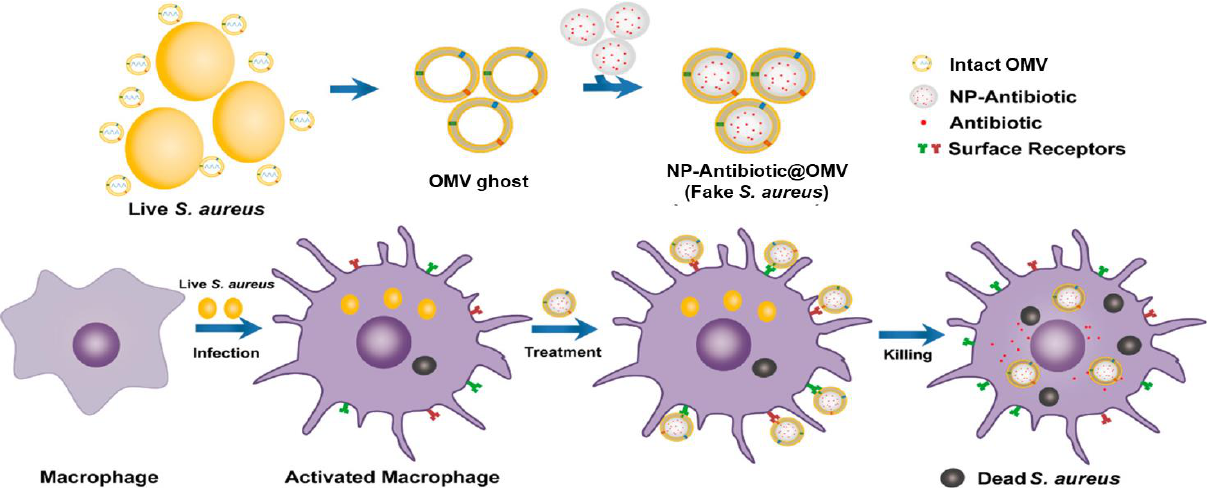
Figure 5. Schematic of the preparation of NP@OMV and its antibacterial activity. Reproduced with permission from Reference [9], copyright American Chemical Society.